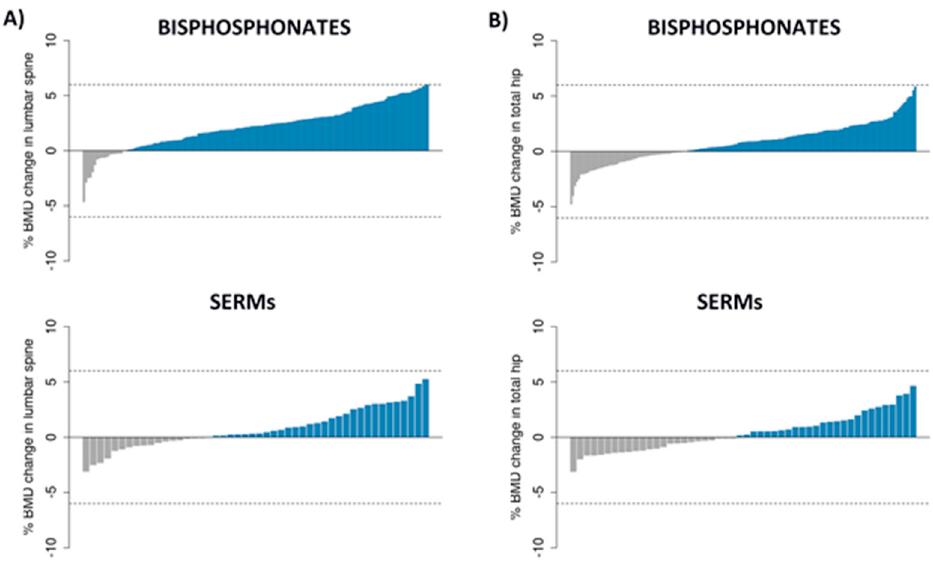
Figure 1. Distribution of the BMD change (as percent of baseline) in each region analyzed: ( A ) lumbar spine; and ( B ) total hip. Dotted lines are the limits for an absolute change value greater than 6%.